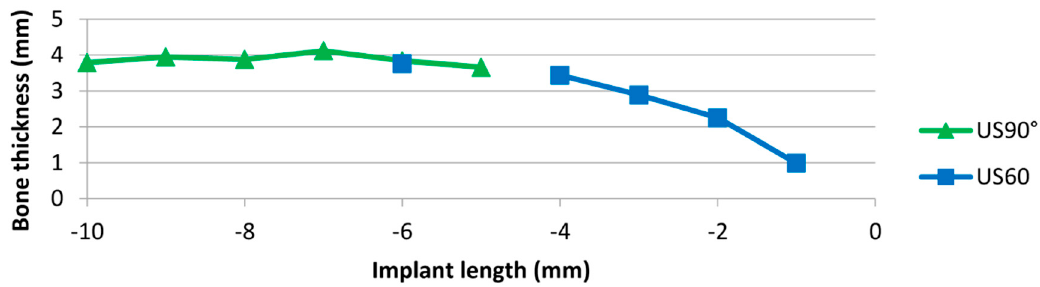
Figure 8. Bone thickness vs. implant depth for ultrasound at 60 ° and 90°.